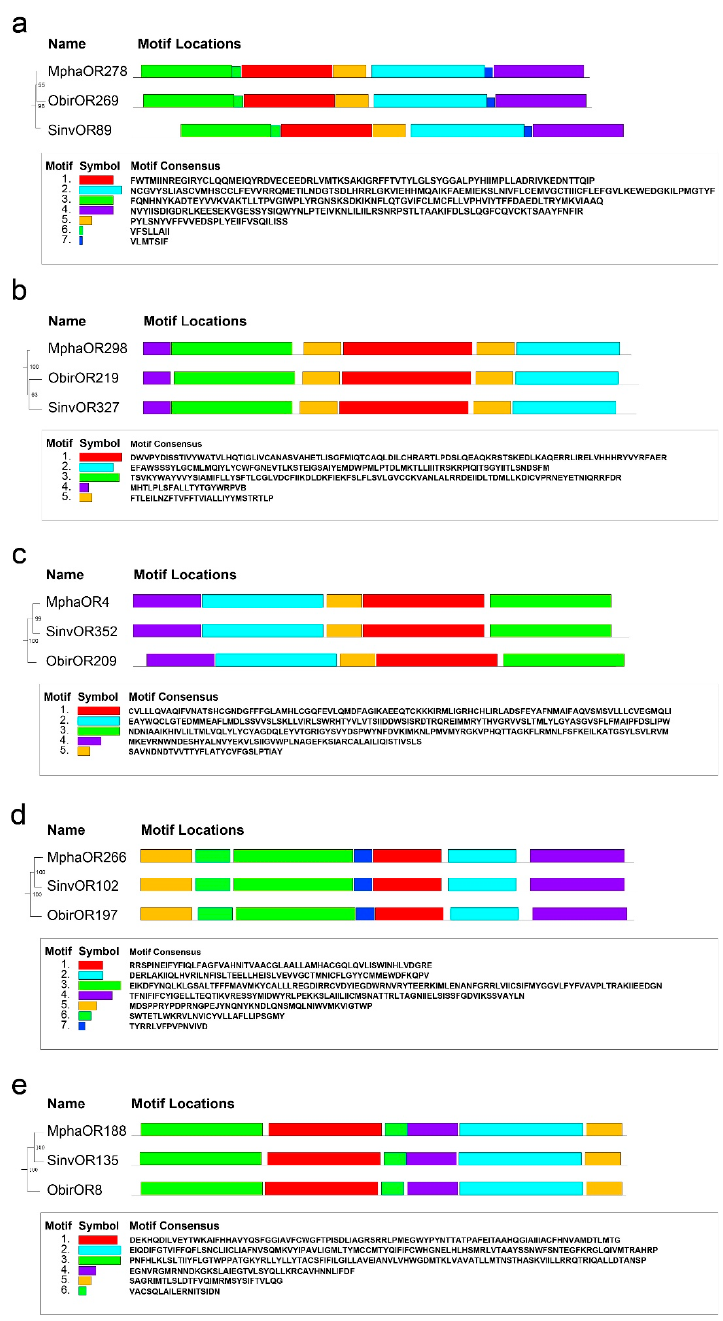
Figure 5. Schematic distribution of motifs found in highly conserved OR proteins in three Formicidae species. They are SinvOR89 ( a ), SinvOR327 ( b ), SinvOR352 ( c ), SinvOR102 ( d ) and SinvOR135 ( e ). Motif analysis was carried out using MEME software (version 5.3.0). The colored boxes represent conserved motifs in each